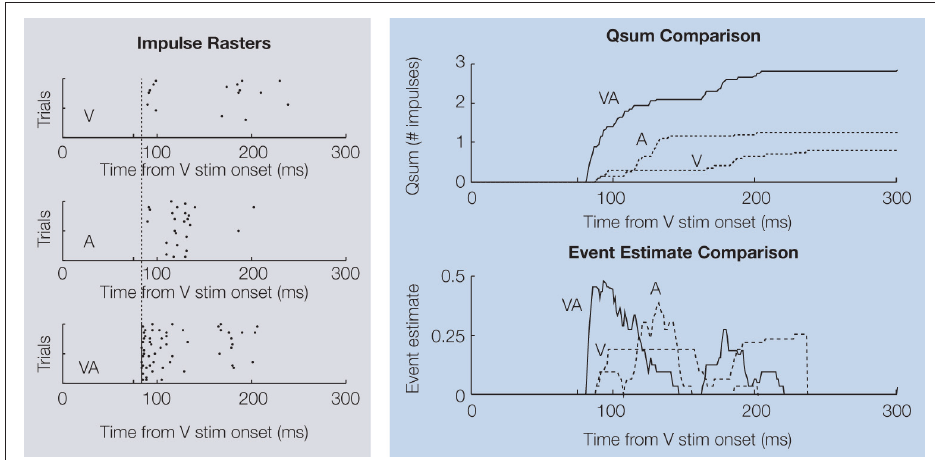
Figure 3 | Multisensory integration reflects an initial response enhancement (IRE). Shown is a dramatic example of initial response enhancement from a single visual-auditory SC neuron. Impulse rasters for visual (V), auditory (A), and multisensory (VA) responses are displayed on the left. The vertical line crossing each plot indicates the time of the multisensory response onset, with respect to which the unisensory responses are delayed. The differences between the multisensory and unisensory qsums (upper-right) and event estimates (lower-right) are striking. The multisensory response not only evidences a shorter latency, but is greatly enhanced in robustness from its very